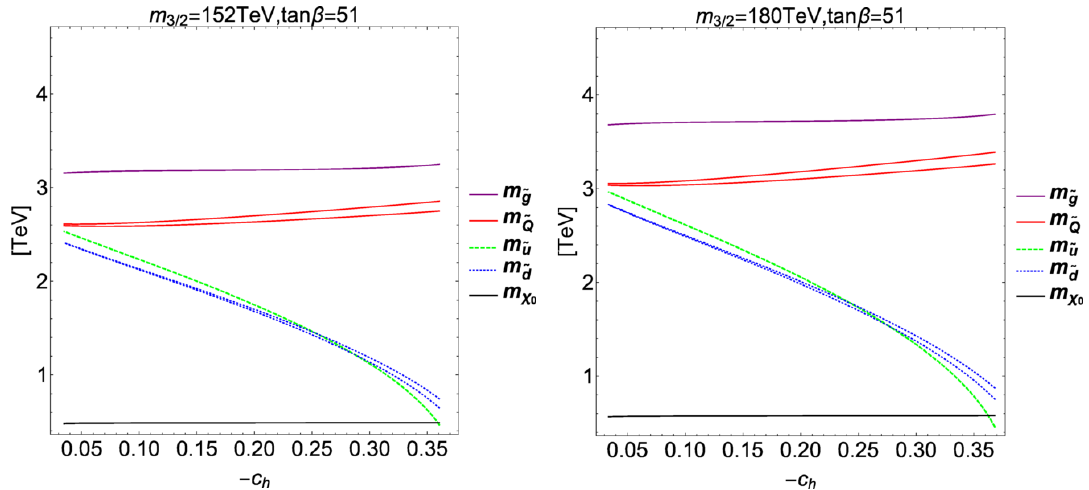
Figure 2 . The mass spectra of colored sparticles. The gravitino mass and tan (cid:12) are (cid:12)xed as m = 152 TeV and tan (cid:12) = 51 ( m = 180 TeV and tan (cid:12) = 51) in the left (right) panel. The 3 = 2 3 = 2 black solid line denotes the wino mass for